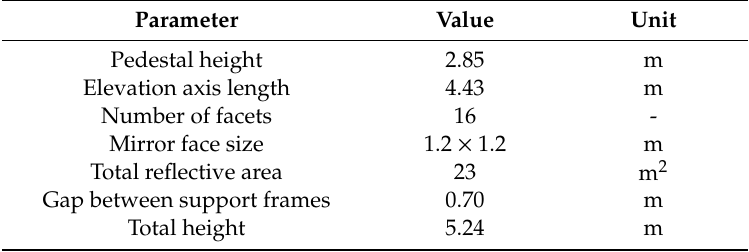
Figure 2. Heliostat design. Table 1. Parameters of the